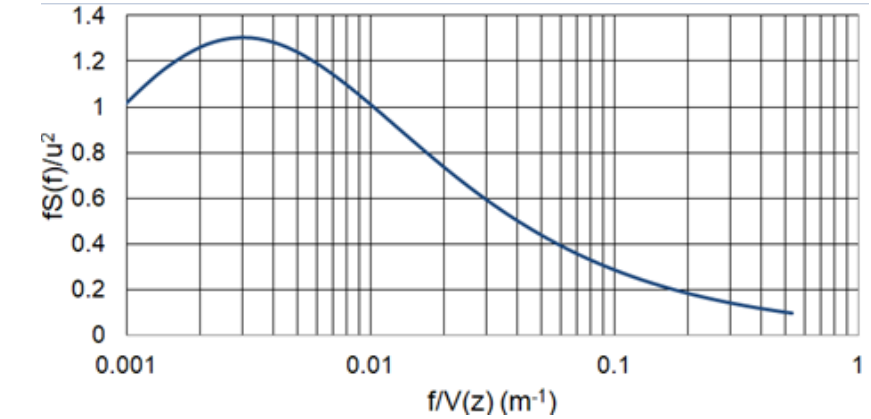
Fig. 1. Kaimal Power Spectral